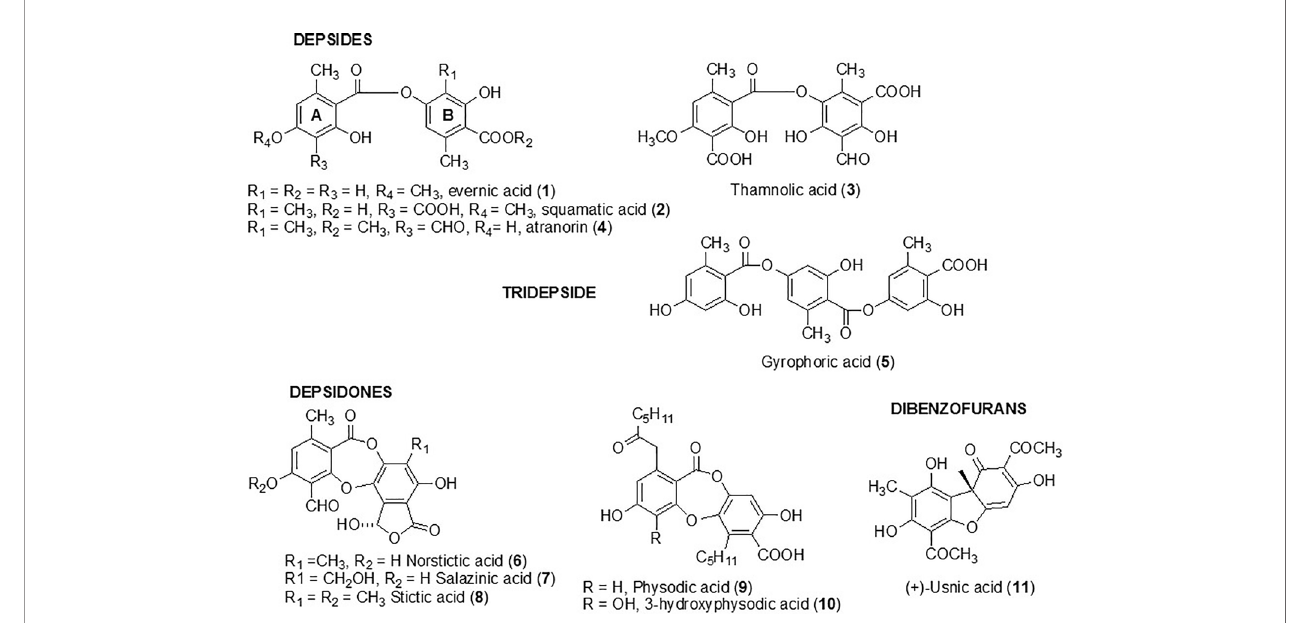
FIGURE 1 | Structure of metabolites tested against bio fi lm Candida albicans